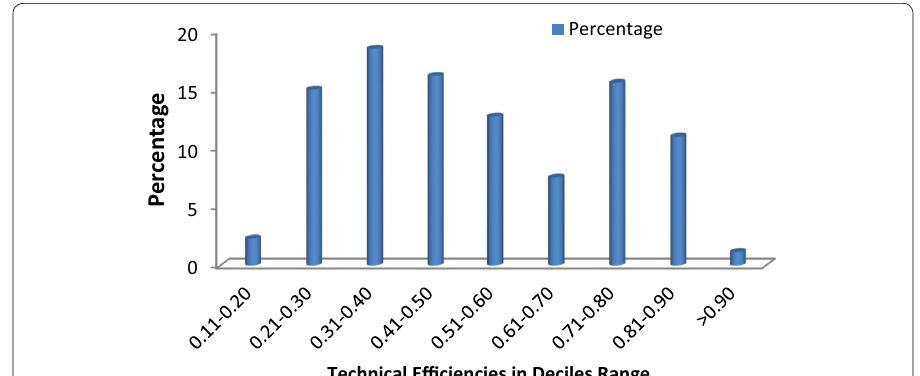
Fig. 3 Frequency distribution of technical efficiency